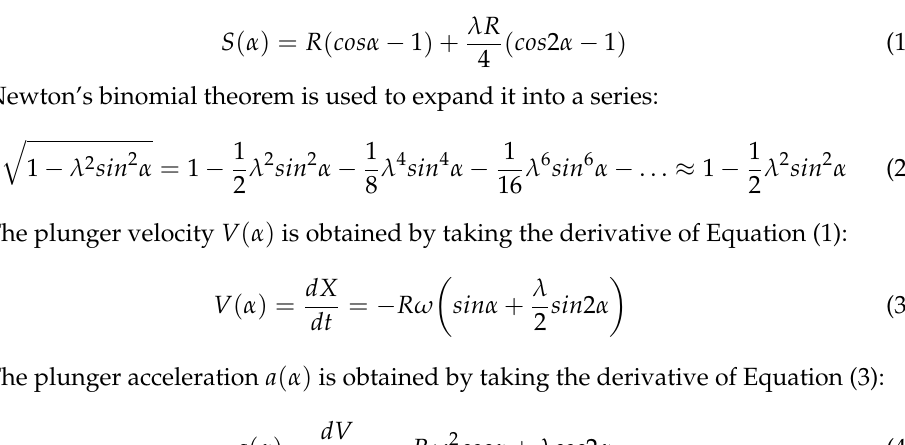
the Z-axis, the xoy coordinate system is established on the middle plane of the crank. In